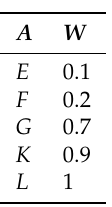
Table 5. Weight table of single attribute